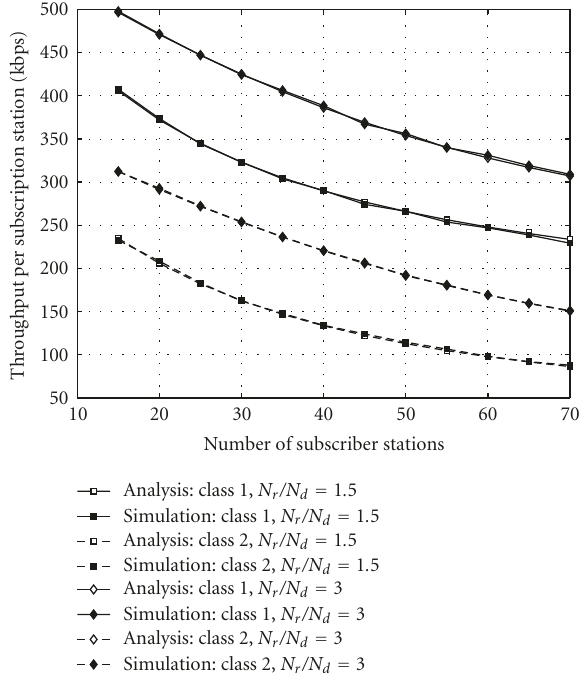
Figure 5: Throughput of single SS versus the number of SSs with equal bandwidth allocation priority and di ff erentiated channel access parameters: W 0,1 = N r , W 0,2 = 3 N r , W x ,1 = 2 4 W 0,1, and W x ,2 = 2 8 W 0,2 .